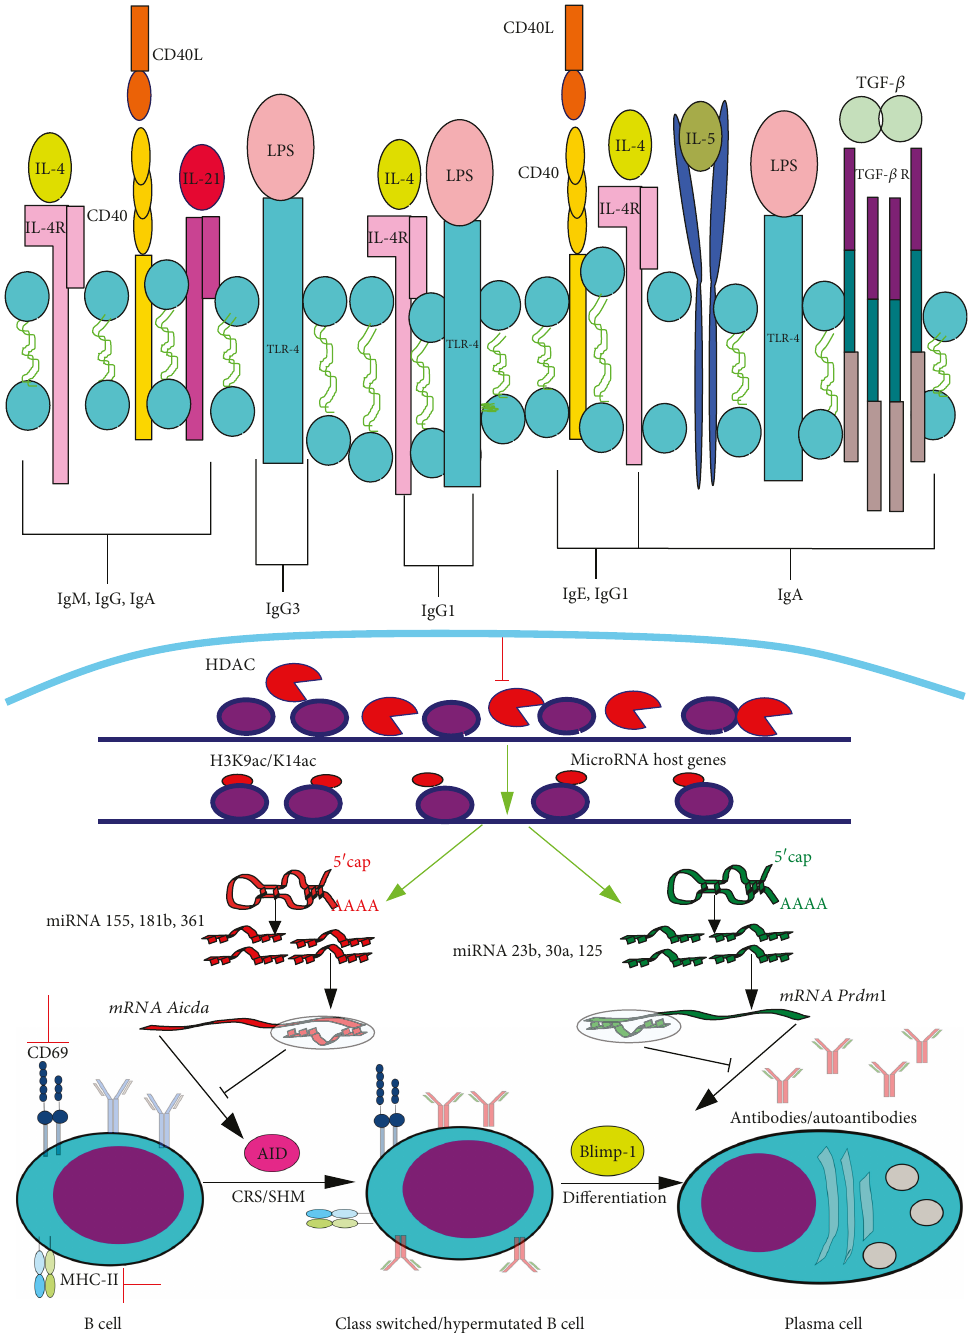
Figure 10: VPA impacts the B cell di ff erentiation into plasma cells and in the isotype switch and maturation a ffi nity of immunoglobulins. There are various signals by which B lymphocytes can di ff erentiate into plasma cells that produce one or another immunoglobulin. CD40L+IL-21 promote IgM production and isotype switch into IgG and IgA; LPS+IL-4 induce isotype switch into IgG1; CD40L and IL-4 enable isotype switch into IgE; and IL-4+IL-5+LPS+TGF- β +dextran-conjugated anti IgD (not shown) prompt isotype switch into IgA. Isotype switch is mainly mediated by AID expression, while the naïve B lymphocyte di ff erentiation into a plasma cell is governed by Blimp-1. VPA interferes with those mechanisms by inhibiting several HDACs, which promotes an increase in acetylation of the H3 that is next to the codifying genes for multiple miRNAs, which then block mRNA for AID ( Aicda ) and for Blimp-1 ( Prdm1 ). Besides, VPA inhibits the expression of the early activation molecule CD69 and of MHC-II. Furthermore, this e ff ect could be employed to reduce the generation of autoantibodies in mouse experimental lupus models. Green arrows indicate the processes, molecules, or mediators in the signaling pathway that are augmented and/or promoted by VPA. Red arrows indicate processes, molecules, or mediators in the signaling pathway that are inhibited by VPA. Figure based on